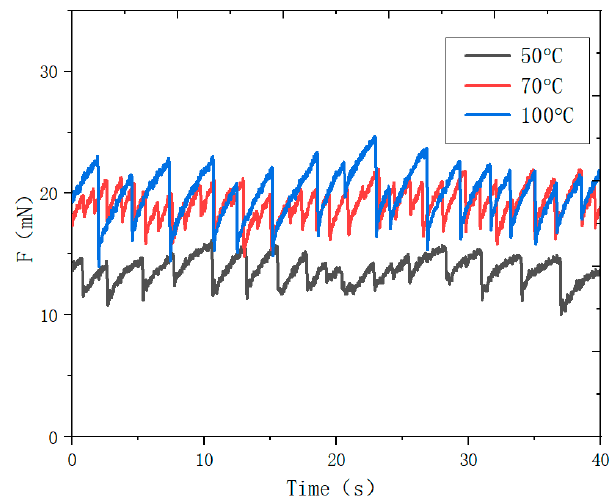
Figure 5. The variation curves of the friction of theconcrete material with time at three different temperatures.